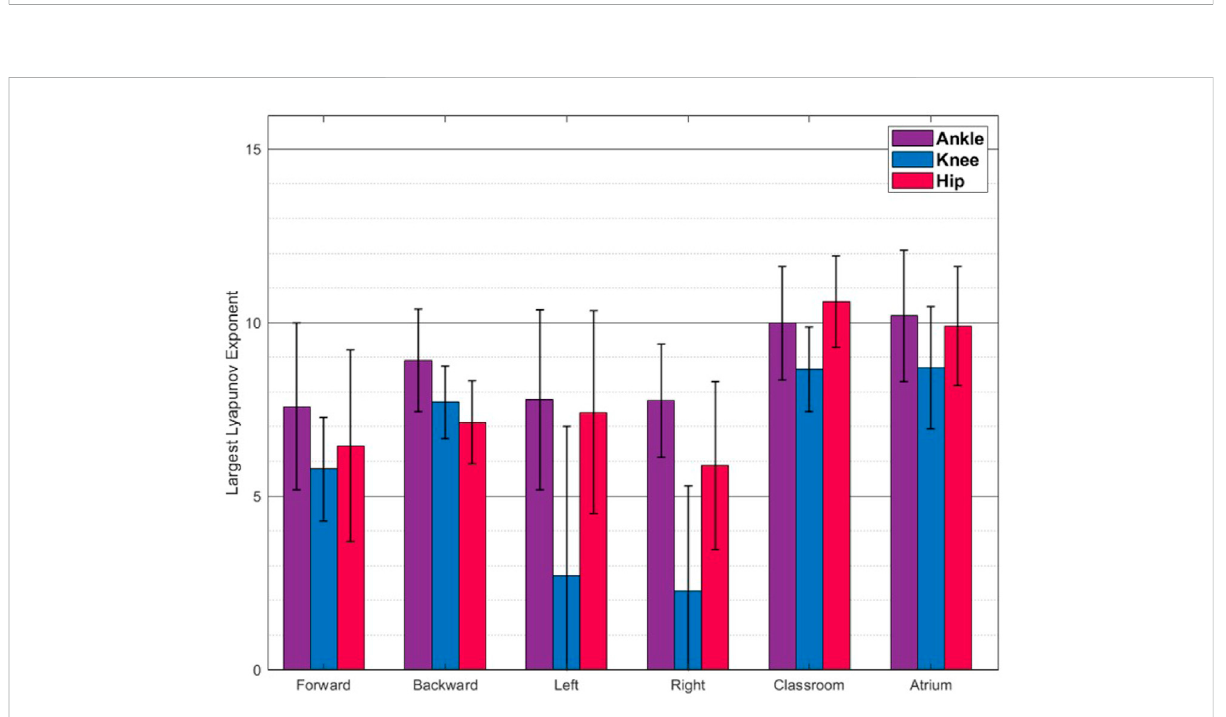
FIGURE 7 Largest Lyapunov Exponent(Mean ± SD) The values reported are mean and standard deviation across the trials from all the subjects. Walking in classrooms and atrium shows greater complexity than other